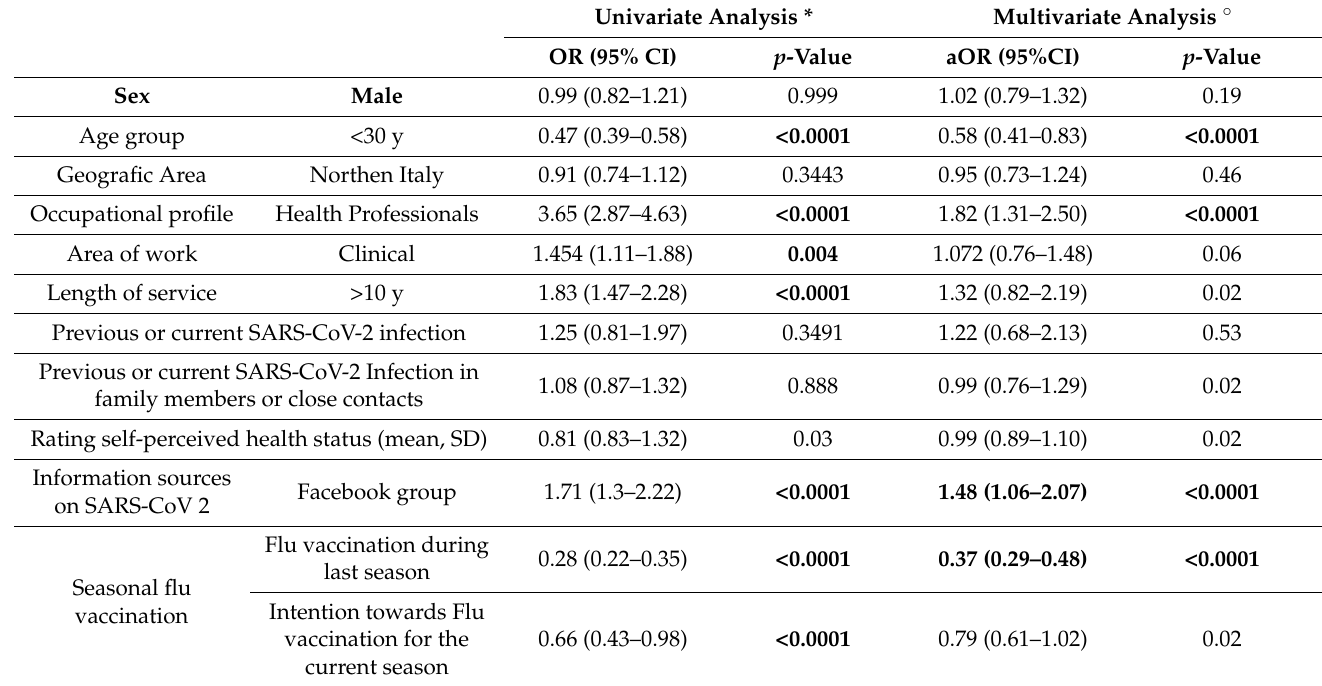
Table 3. Predictors of COVID-19 vaccine